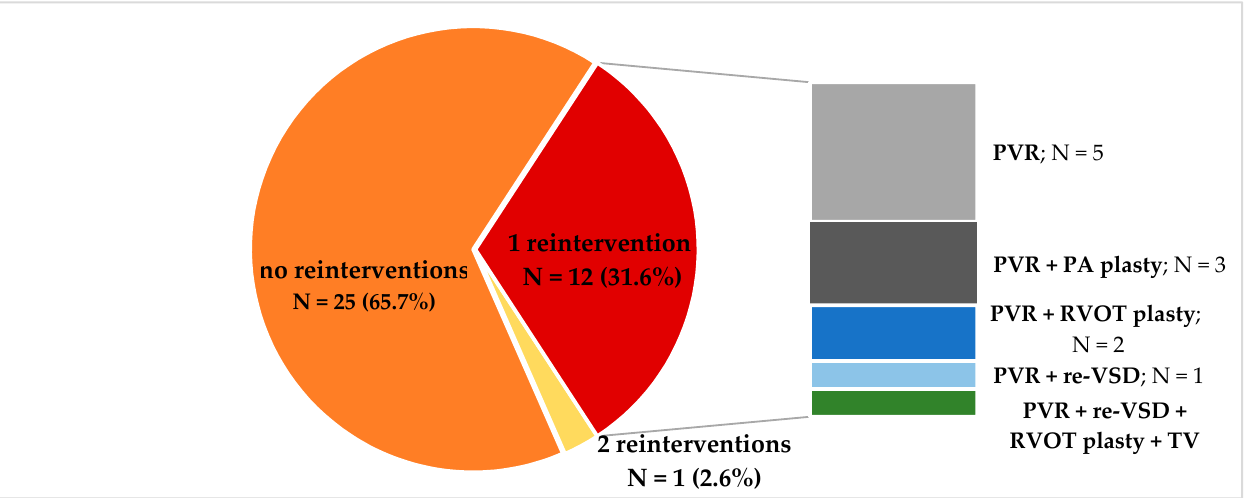
Figure 1. Surgical reinterventions after TOF repair; PVR = pulmonary valve replacement, PA = pulmonary artery; RVOT = right ventricular outflow tract; re-VSD = residual postsurgery ventricular septal defect.